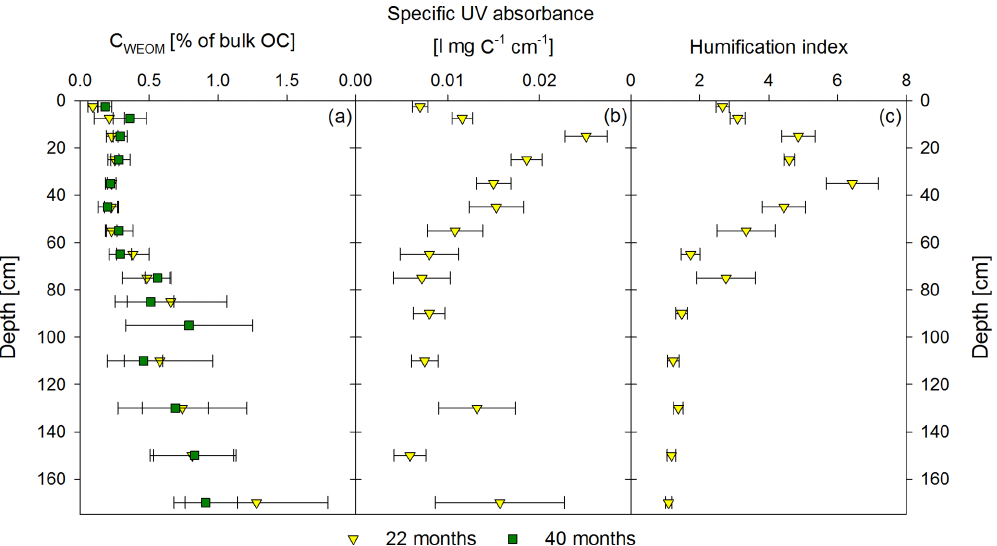
Figure 4. Mean proportion of water-extractable OC (C WEOM ) per depth increment given in percentage of the total soil OC in bulk soil for both sampling times, 22 months and 40 months after labeled litter application ( n = 6; error bars represent the standard deviation) is shown in (a) . Specific UV absorbance at 280nm (b) and humification index deduced from fluorescence spectra (c) of the water extracts are given as the mean ( n = 6) of the first sampling in November 2016. Error bars represent the standard